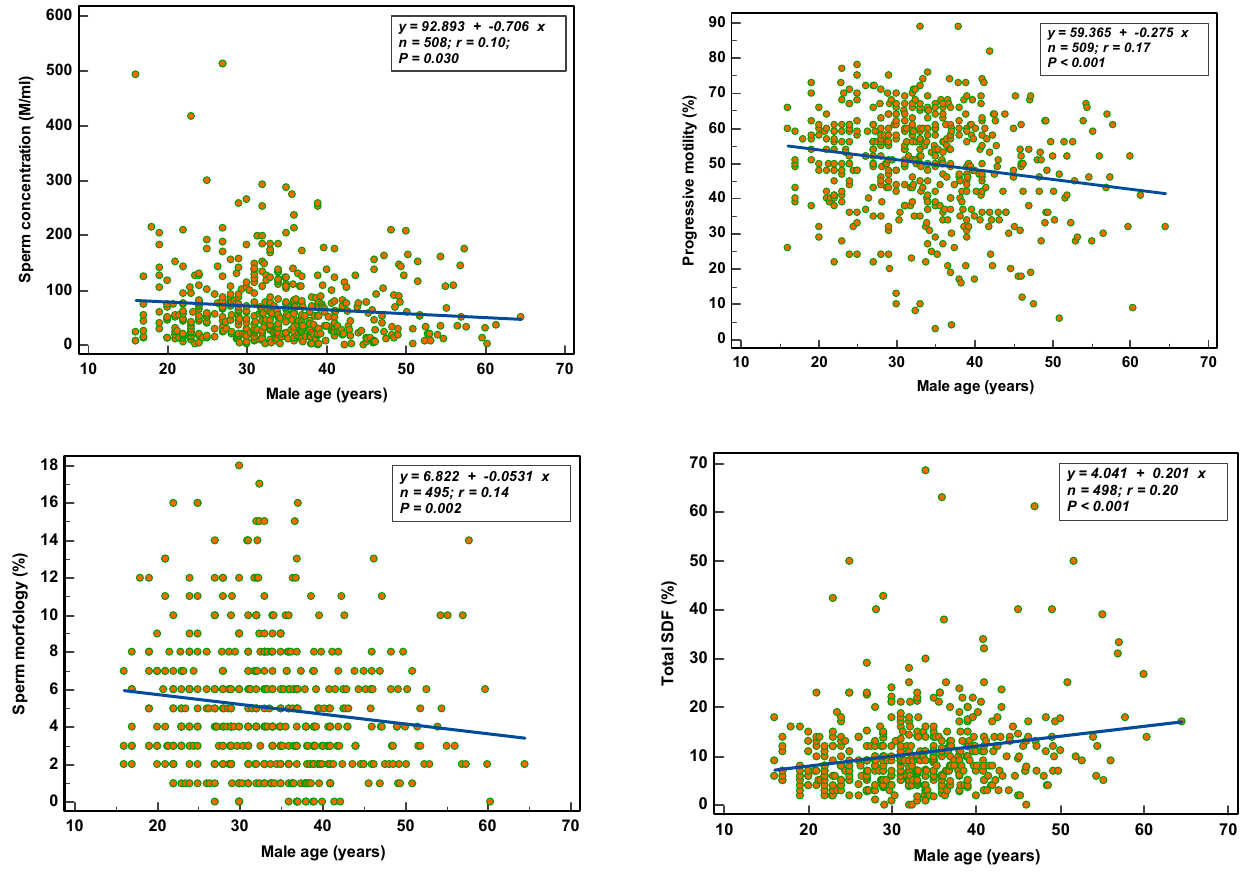
Figure 2. Age-related effects on semen parameters and total